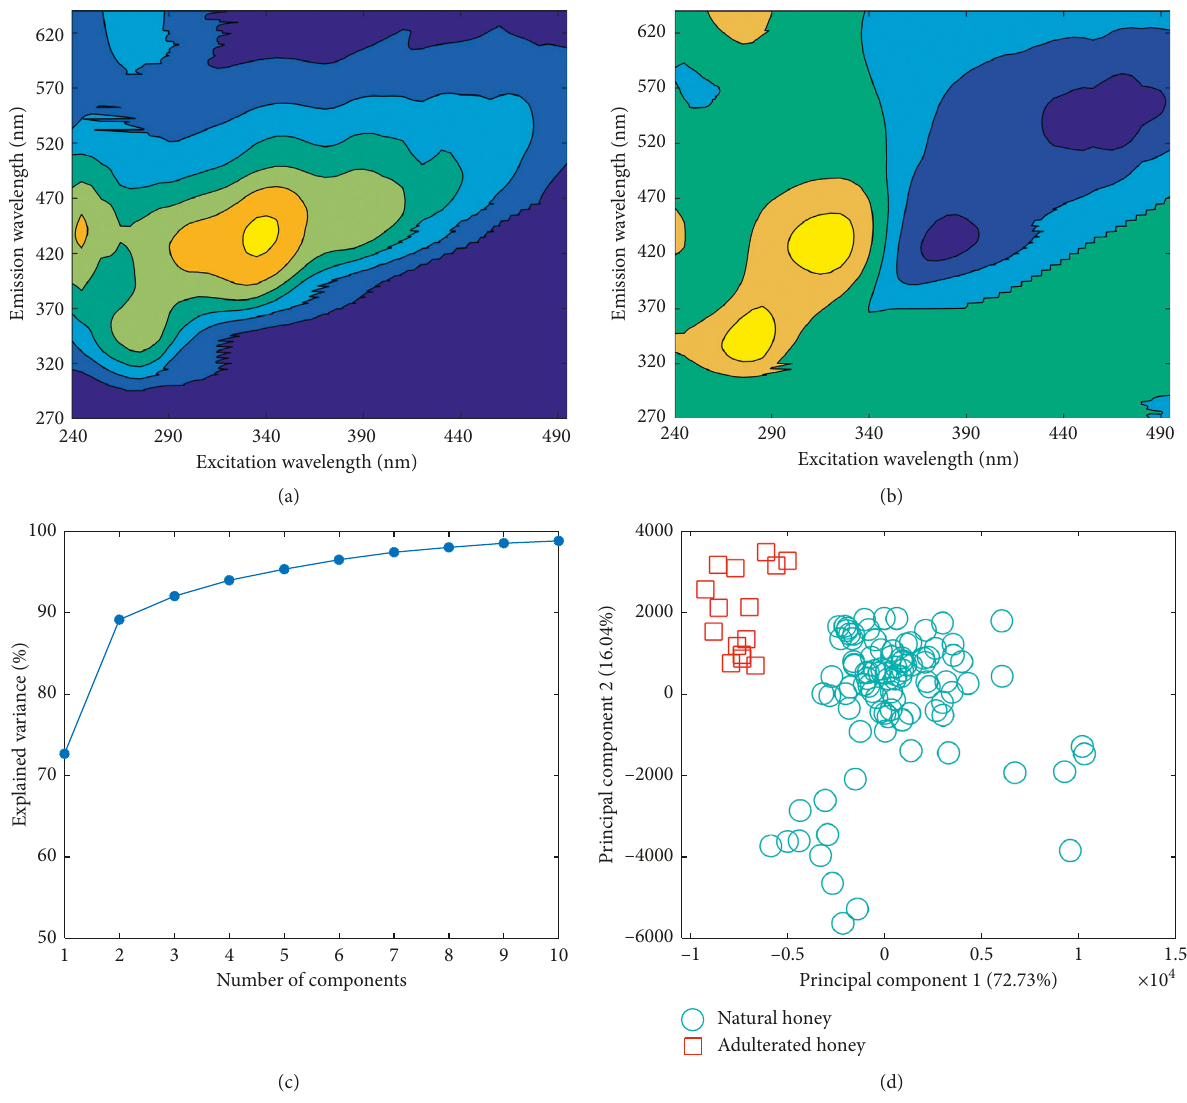
Figure 2: Results of PCA of unfolded honey EEM spectra: (a) loadings of the first principal component, (b) loadings of the second principal component, (c) cumulative variance plot, and (d) the PCA score Table 1, fluorescence EEMs of honey are characterized by 5 spectral regions of high emission intensities: (1) excitation: 240–265 nm, emission: 370–495 nm; (2) excitation: 280–